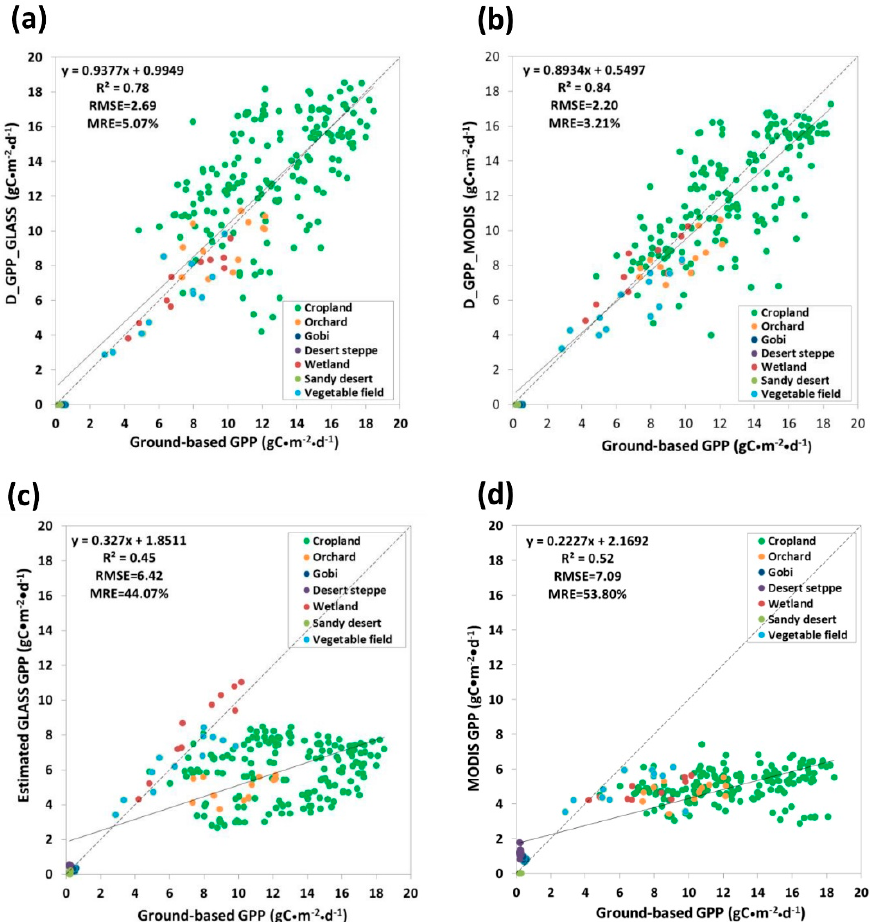
Figure 12. Validation of GPP against ground measurement: ( a ) Validation of D_GPP_GLASS; ( b ) validation of D_GPP_MODIS; ( c ) validation of estimated GLASS GPP; ( d ) validation of MODIS GPP.